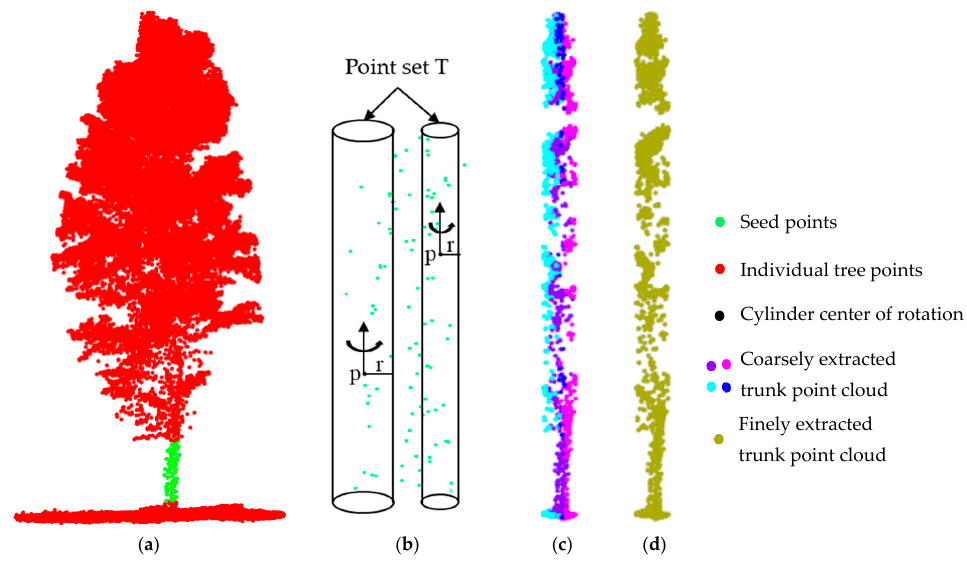
Figure 5. Trunk point extraction. ( a ) The point cloud of an individual tree, ( b ) multiscale cylindrical construction, ( c ) coarse extraction of the trunk point cloud, and ( d ) fine extraction of the trunk point cloud.